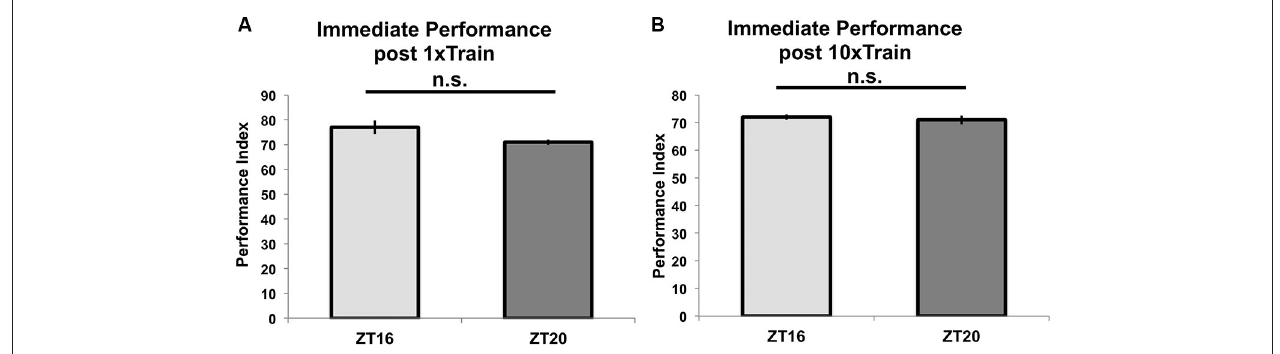
presented as experimental means with error bars representing SEM. Flies trained with a single trial at ZT16 and ZT20 show statistically similar learning scores ( p = 0.09). Likewise, flies given 10x spaced olfactory conditioning perform similarly ( p = 0.8) when tested immediately after training.